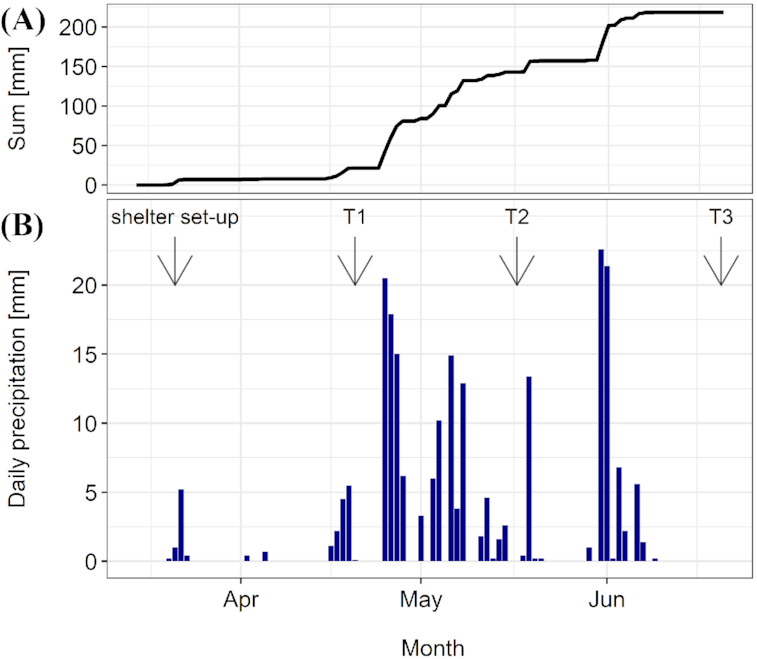
Precipitation levels (mm) on the study site. (A) Cumulative precipitation; (B) daily precipitation sum; arrows show start of the experiment (rainout shelter set-up) and the three sampling dates conducted 4 (T1), 8 (T2) and 13 (T3) weeks after rainout shelter set-up.